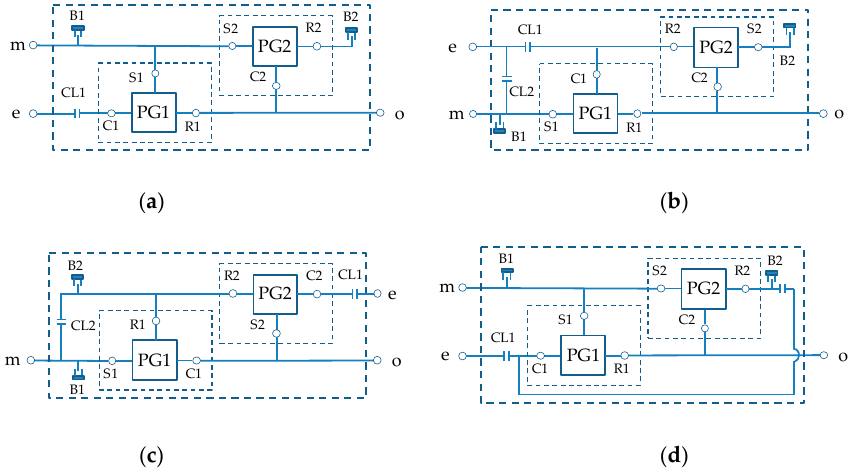
Figure 14. Port diagram of typical architecture developed by ( a ) Tsai; ( b ) Zhu; ( c ) Chachra; ( d ) Tsai.